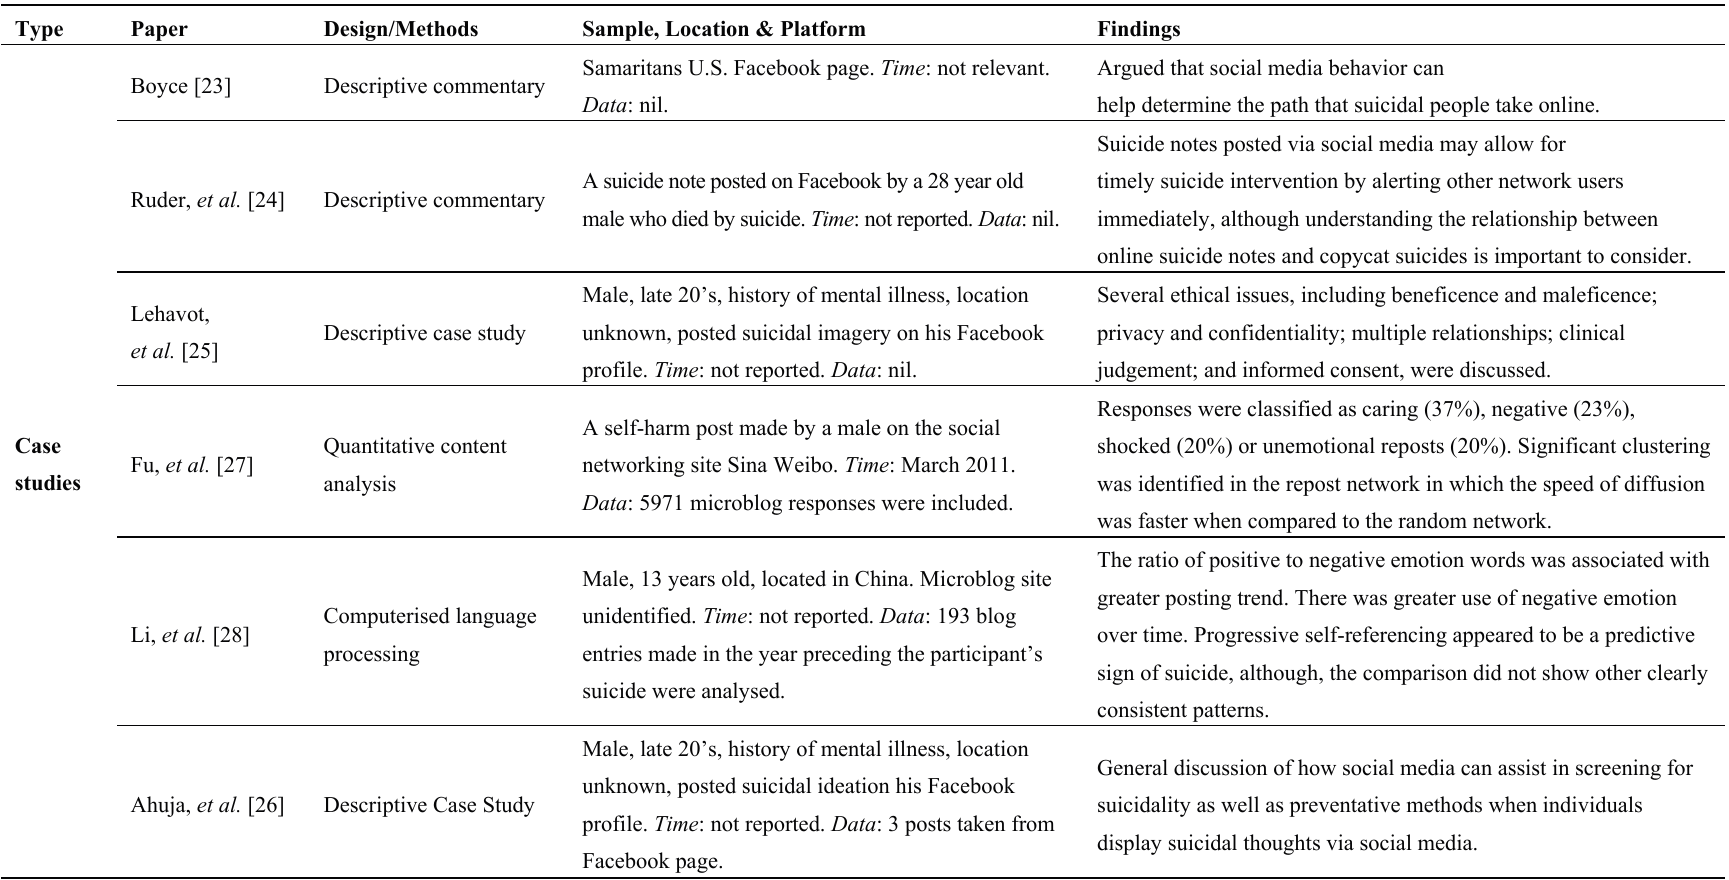
Table 3. Articles related to social media for suicide